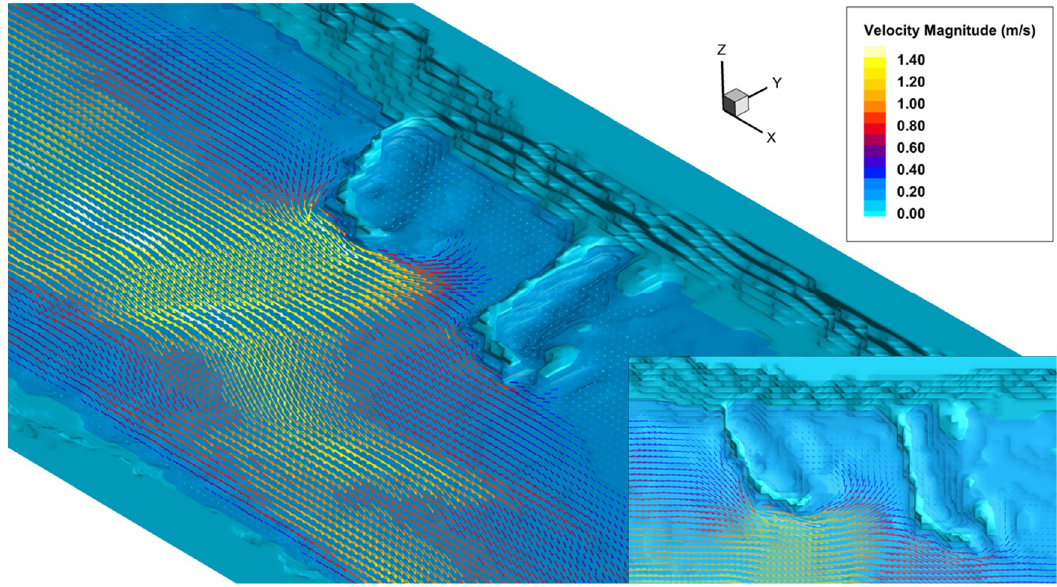
Figure 8. The numerical results on 3D flow field of the double-spur dikes case under non-submerged flood conditions (figure at bottom right shows the local flow field around the spur dikes with top view).